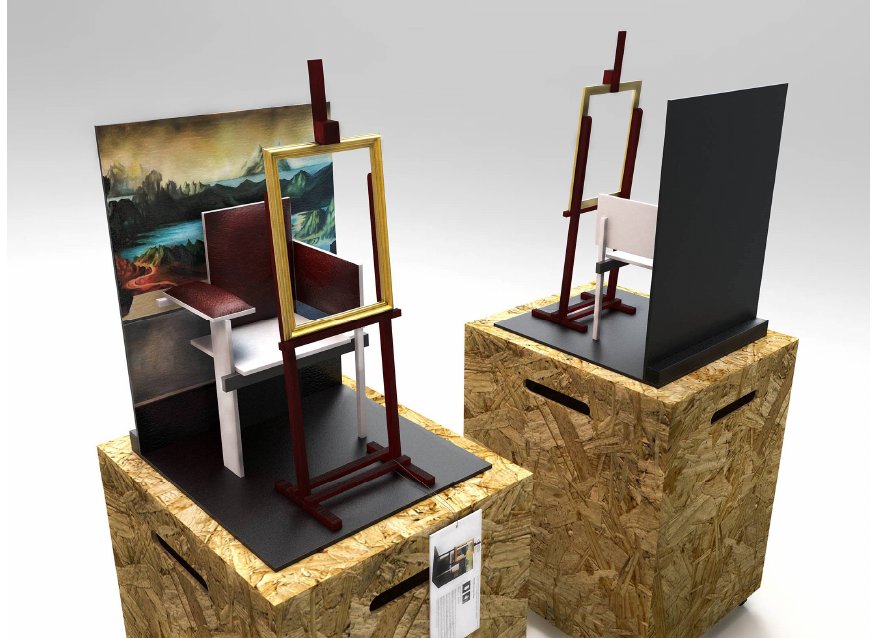
Figure 3. Maria Virgilia Manzoni, Annalisa Marchetti: “ Hypertime